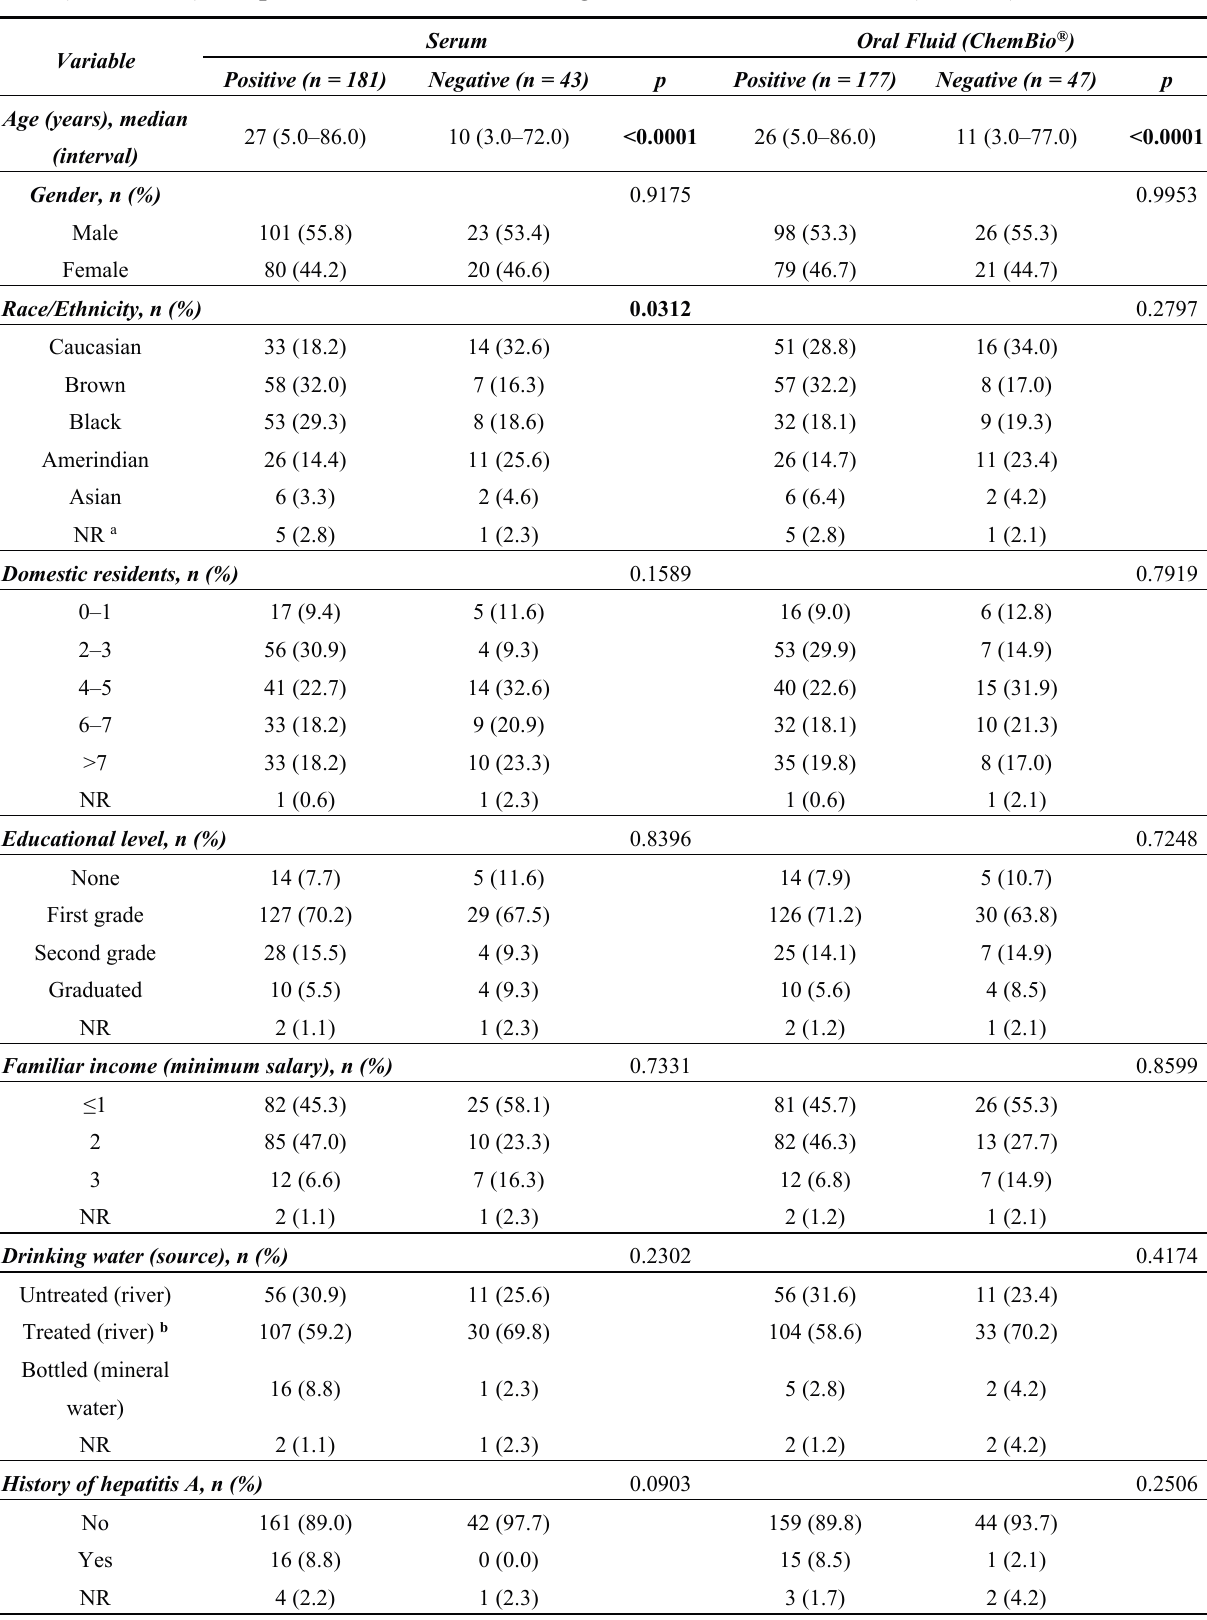
Table 2. Factors associated with anti-HAV antibodies positivity in serum and oral fluid (Chembio ® ) samples from individuals living in South Pantanal, Brazil ( n =